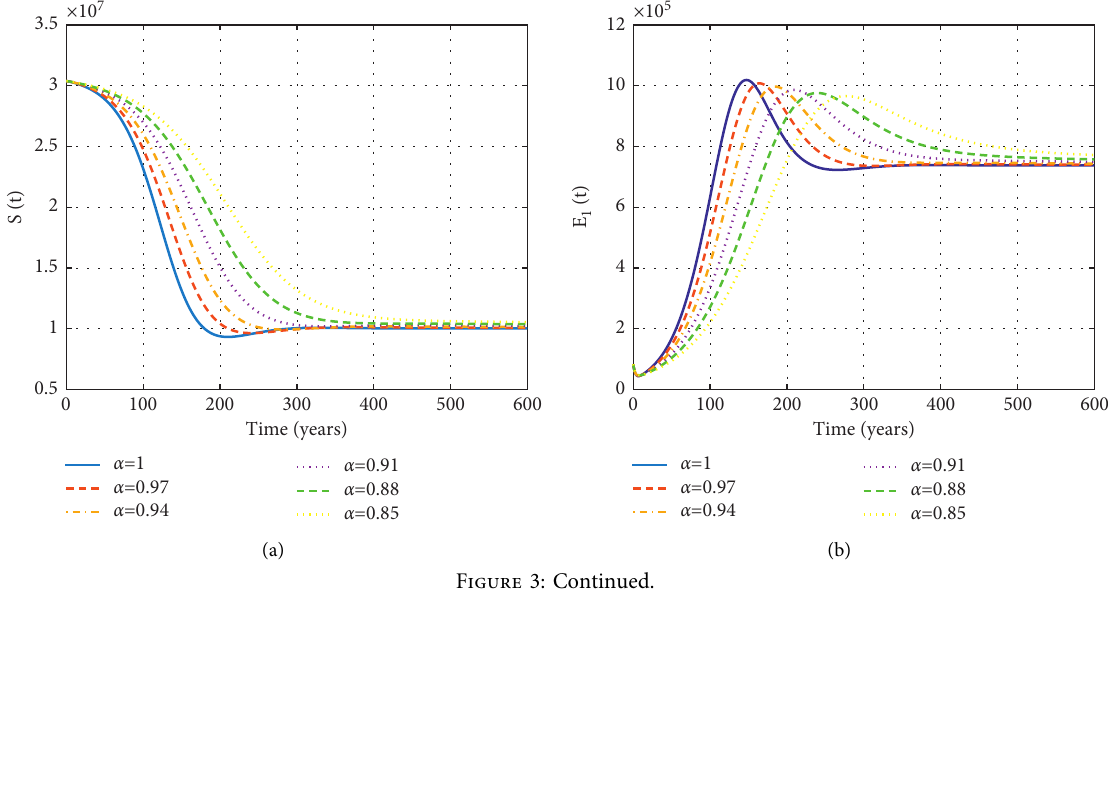
> 1 (a) and R < 1 (b). 0 0